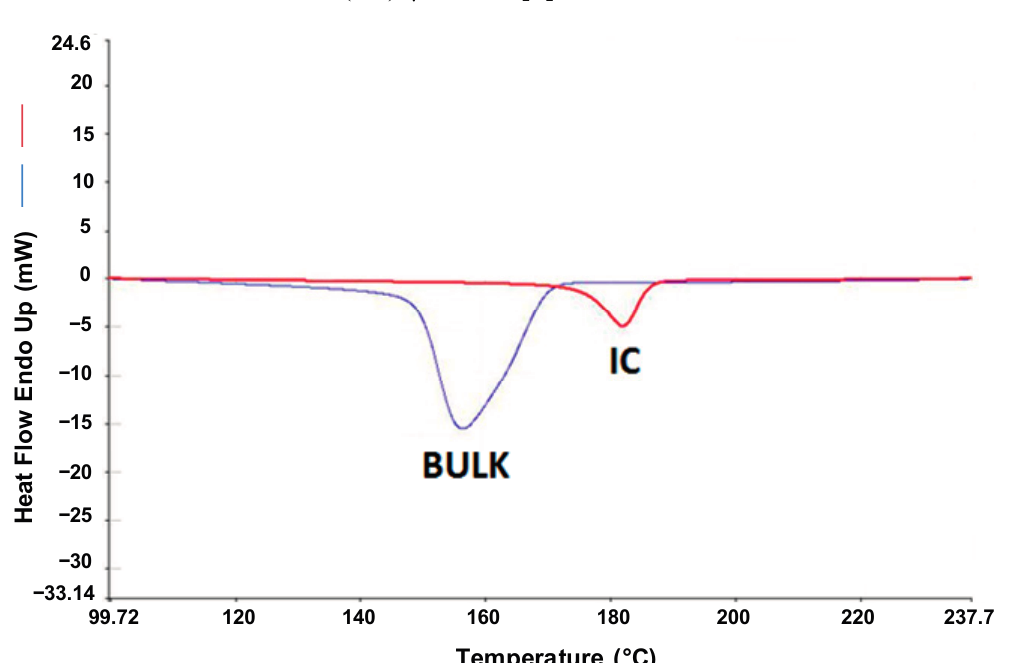
Figure 3. Differential Scanning Calorimetry (DSC) cooling scans from the melts